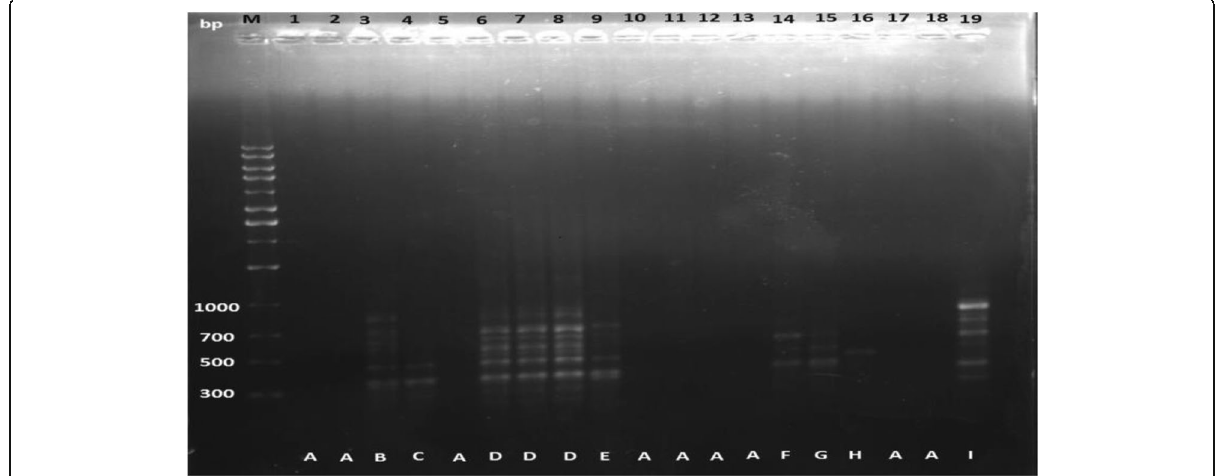
Fig. 1 RAPD agarose gel electrophoresis with OPR 02 (5 ′– CAC AGC TGC C-3 ′ ) primer. Same alphabet indicates identical banding pattern. A, Non- type-able DNA; bp, Base pairs; M, 1 kb DNA molecular marker. 1, FARO-44 (control); 2, FARO-52 (control); 3, FARO-57 (control); 4, NERICA L-34 (control); 5, NERICA L-47 (control); 6, FARO-44 (0% NaN 3 ); 7, FARO-44 (0.004% NaN 3 ); 8, FARO-44 (0.016% NaN 3 ); 9, FARO-52 (0.004% NaN 3 ); 10, FARO-52 (0.008% NaN 3 ); 11, FARO-52 (0.016% NaN 3 ); 12, FARO-57(0% NaN 3 ); 13, FARO-57 (0.008% NaN 3 ); 14, FARO-57 (0.016% NaN 3 ); 15, NERICA L- 34 (0% NaN 3 ); 16, NERICA L-34 (0.004% NaN 3 ); 17, NERICA L-47 (0% NaN 3 ); 18, NERICA L-47 (0.008% NaN 3 ); 19, NERICA L-47 (0.004% NaN 3